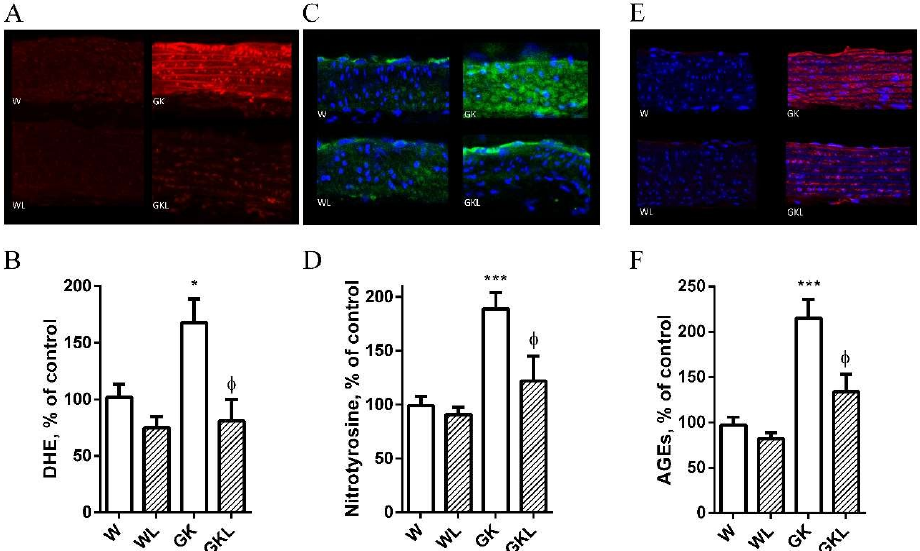
Figure 4. Effects of luteolin treatment on vascular oxidative stress and advanced glycation end-products’ levels in Wistar (W) and diabetic Goto-Kakizaki (GK) rats. Representative DHE-stained aorta artery sections reflect O 2 ● − production in W and GK rats with (WL, GKL) or without luteolin treatment (W, GK). (Panel A ). The endothelium is facing up in all layers. At identical settings, fluorescence (reflecting O 2 ● − levels in the endothelium, intima, and media) in diabetic GK was markedly increased compared to age-matched control W rats. DHE fluorescence decreased in the diabetic GK rats treated with luteolin (GKL). Panel ( B ) contains quantification of the fluorescence ethidium signal in the different groups of arteries. Representative aortic sections showing nitrotyrosine staining (panel C ) in W and GK rats with (WL, GKL) or without luteolin treatment (W, GK). Panel ( D ) contains quantification of the green fluorescence in the different groups of arteries. Representative aortic sections showing AGE staining (panel E ) in W and GK rats with (WL, GKL) or without luteolin treatment (W, GK). Panel ( F ) exhibits quantification of the red fluorescence in the various groups of arteries. Data are expressed as mean ± SE ( n = 10). * p < 0.05, *** p < 0.001 vs. W group; ϕ p < 0.05 vs. GK group.